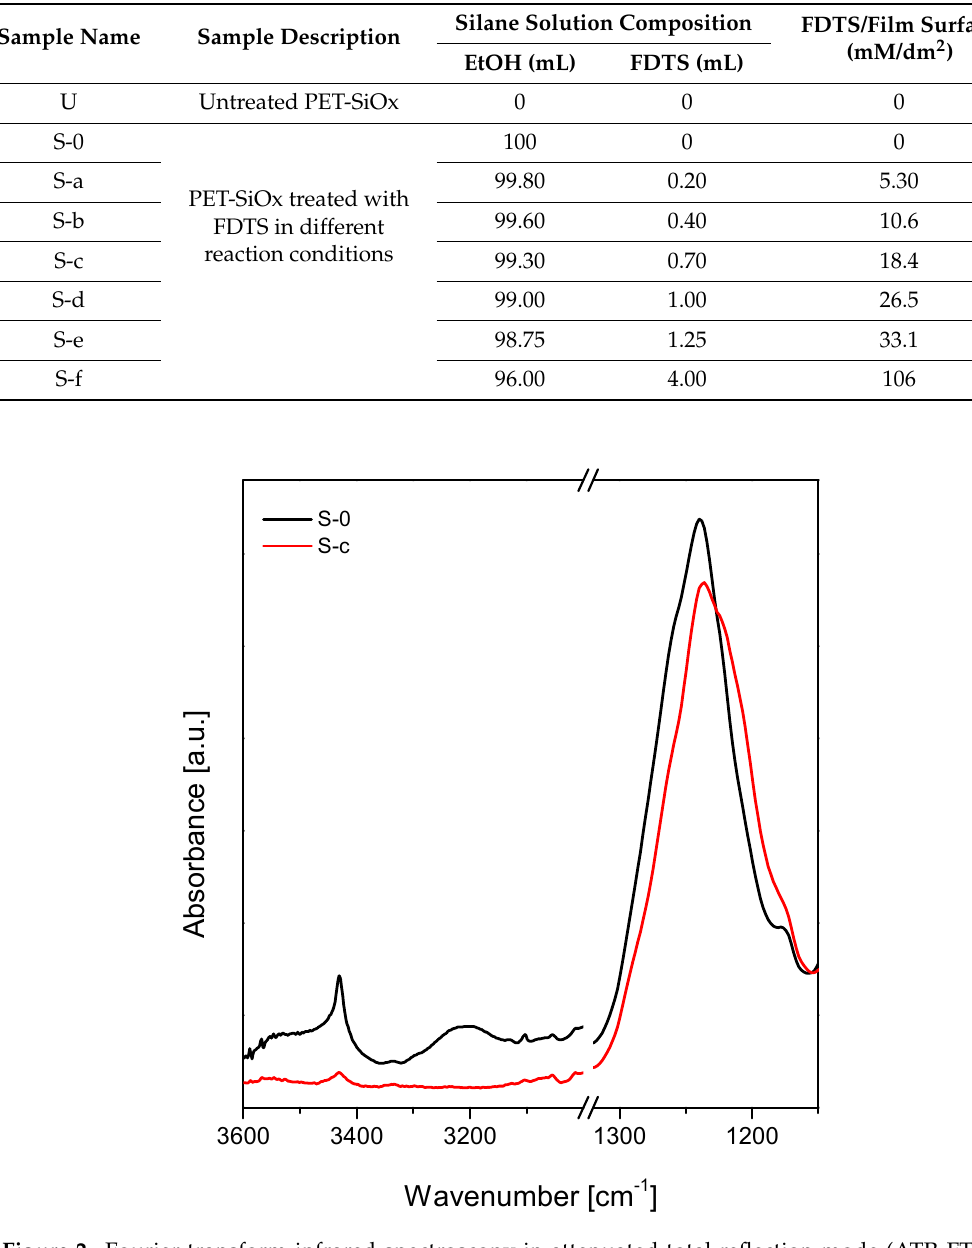
Figure 2. Fourier transform infrared spectroscopy in attenuated total reflection mode (ATR-FTIR) spectra of PET-SiOx film before (S-0) and after (S-c) FDTS condensation.